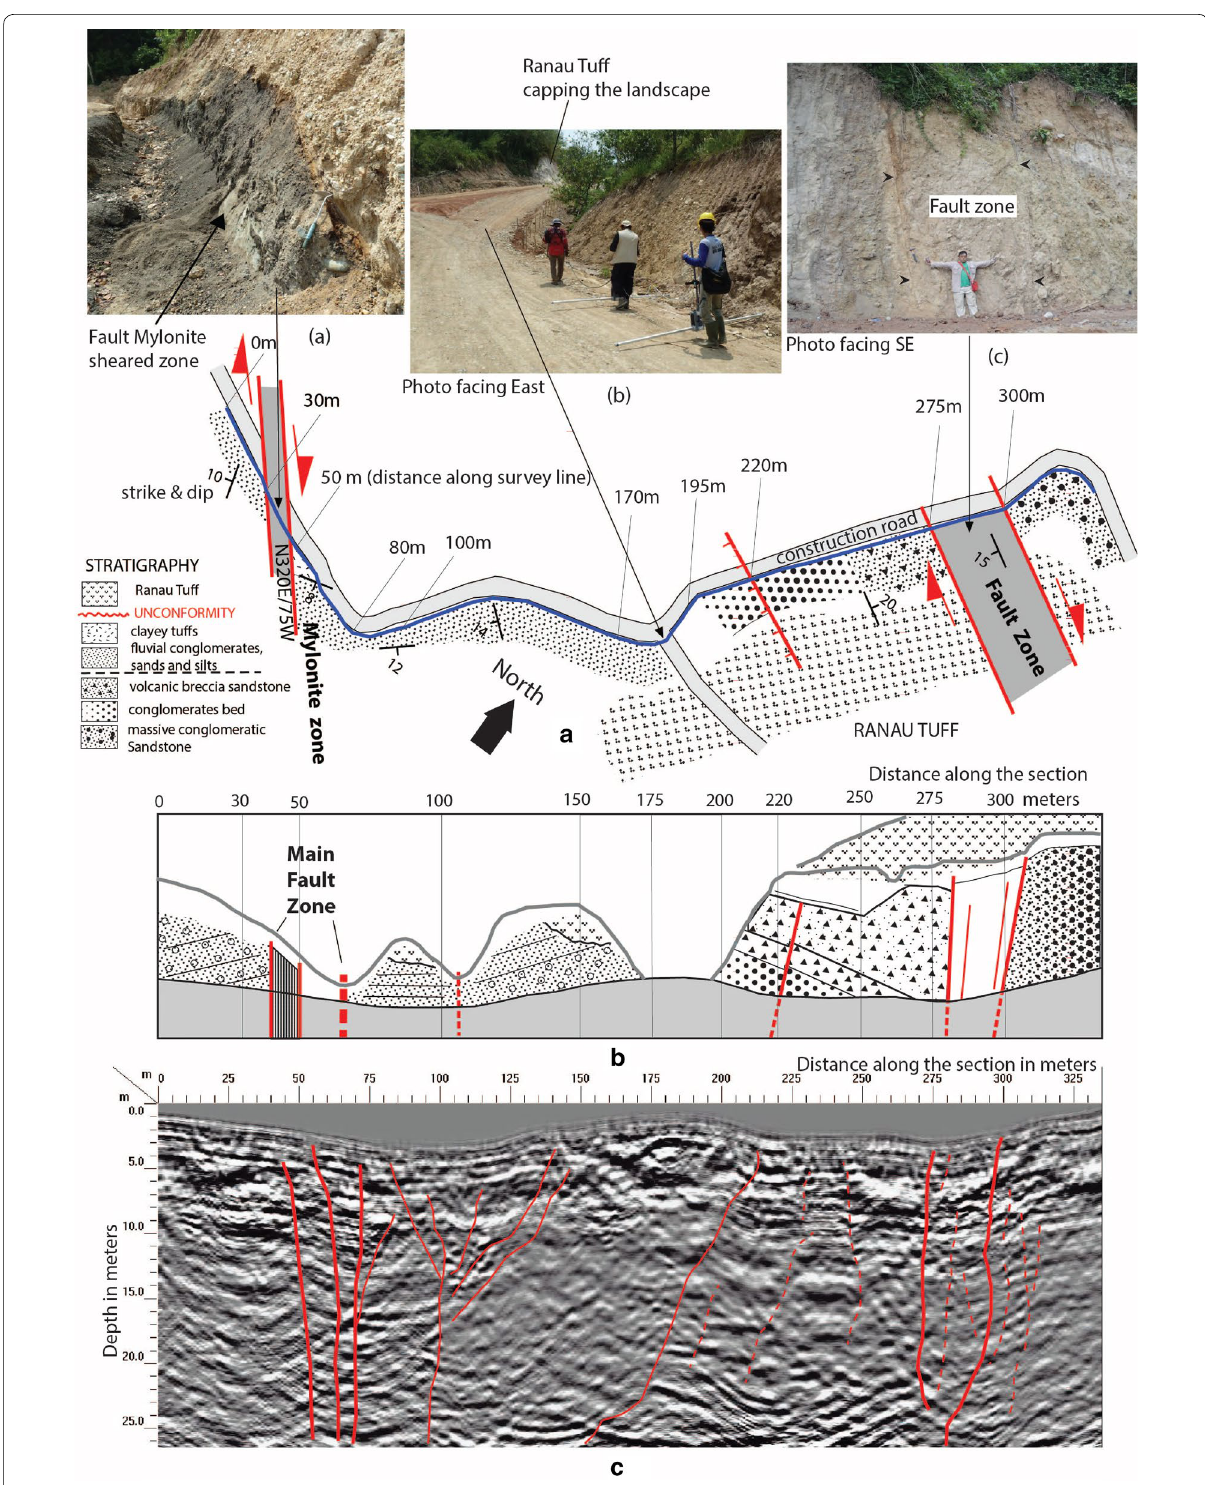
Fig. 12 Geological sections and radargram GPR along Survey Line 3 (location marked in Fig. 13) crossing west Semangko segment. a Geological map and stratigraphy along the survey line ; a, b, c are photographs of the outcrops on cliff along the line . b Schematic geological cross section facing the cliff along the survey line . c Ground Penetration Radar profile (radargram) along the survey line correlated to